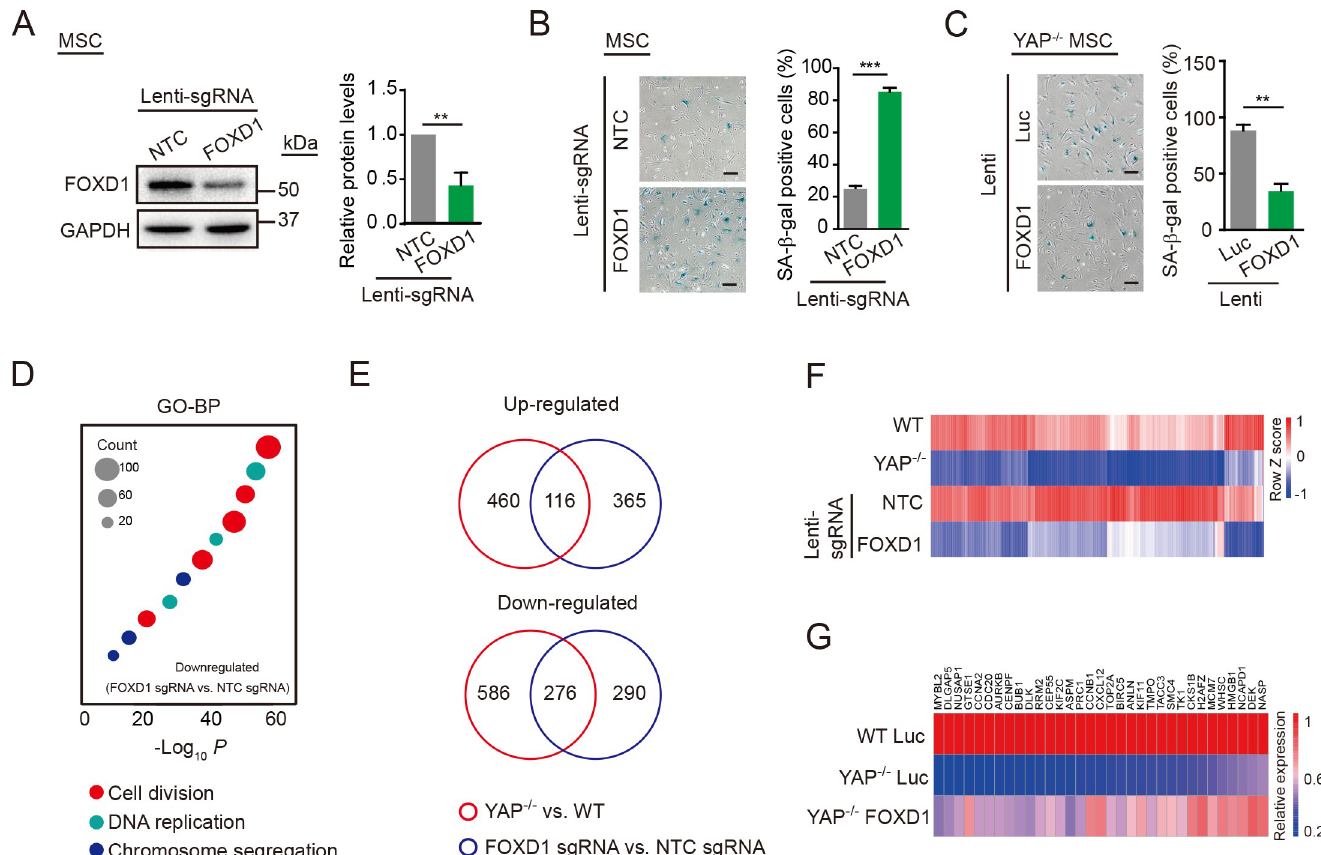
Fig 4. FOXD1 mediates YAP deficiency-induced senescence. (A) Western blot analysis of FOXD1 in hMSCs transduced with lentiviruses expressing NTC or FOXD1 sgRNA, as well as CRISPR/Cas9. GAPDH was used as a loading control (left). The protein levels normalized with GAPDH were shown as fold change relative to lenti-NTC sgRNA transduced hMSCs (right). Data are presented as the mean ± SD, n = 3, �� P < 0.01. (B) SA- β -gal staining of hMSCs transduced with lentiviruses expressing NTC or FOXD1 sgRNA, as well as CRSPR/Cas9. Scale bar, 100 μ m. Data are presented as the mean ± SD, n = 3, ��� P < 0.001. (C) SA- β -gal staining of YAP − / − hMSCs transduced with lentiviruses expressing Luc or FOXD1. Scale bar, 100 μ m. Data are presented as the mean ± SD, n = 3, �� P < 0.01. (D) GO-BP enrichment analysis of down-regulated genes in FOXD1 KO hMSCs. (E) Venn diagram showing differentially expressed genes in both YAP − / − hMSCs (relative to WT) and FOXD1 KO hMSCs (relative to NTC). (F) RNA-seq heat map of the genes that were down-regulated both in YAP − / − and FOXD1 KO hMSCs. (G) RT-qPCR heat map showing the rescue of aging-associated genes by FOXD1 overexpression in YAP − / − hMSCs. The numerical data underlying this figure are included in S8 Data. ANLN, anillin actin binding protein; ASPM, abnormal spindle microtubule assembly; AURKB, aurora kinase B; BIRC5, baculoviral IAP repeat containing 5; BP, biological process; BUB1, BUB1 mitotic checkpoint serine/threonine kinase; Cas9, CRISPR associated protein 9 nuclease; CCNA2, cyclin A2; CCNB1, cyclin B1; CDC20, cell division cycle 20; CENPF, centromere protein F; CEP55, centrosomal protein 55; CKS1B, CDC28 protein kinase regulatory subunit 1B; CRISPR, Clustered Regularly Interspaced Short Palindromic Repeats; CXCL12, C-X-C motif chemokine ligand 12; DEK, DEK proto-oncogene; DLGAP5, DLG associated protein 5; DLK, delta like non-canonical Notch ligand 1; FOXD1, forkhead box D1; GAPDH, glyceraldehyde-3-phosphate dehydrogenase; GTSE1, G2 and S-phase expressed 1; GO, gene ontology; H2AFZ, H2A histone family member Z; HMGB1, high mobility group box 1; hMSC, human mesenchymal stem cell; KIF2C, kinesin family member 2C; KIF11, kinesin family member 11; KO, knockout; lenti, lentivirus; Luc, luciferase; MCM7, minichromosome maintenance complex component 7; MYBL2, MYB proto-oncogene like 2; MSC, mesenchymal stem cell; ns, not significant; NASP, nuclear autoantigenic sperm protein; NUSAP1, nucleolar and spindle associated protein 1; NTC, non-targeting control; PRC1, protein regulator of cytokinesis 1; RNA-seq, RNA sequencing; RRM2, ribonucleotide reductase regulatory subunit M2; RT-qPCR, reverse transcription quantitative polymerase chain reaction; SA- β -gal, senescence-associated- β -galactosidase; sgRNA, single guide RNA; SMC4, structural maintenance of chromosomes 4; TACC3, transforming acidic coiled-coil containing protein 3; TK1, thymidine kinase 1; TMPO, thymopoietin; TOP2A, DNA topoisomerase II alpha; WT, wild type; YAP, Yes-associated protein.